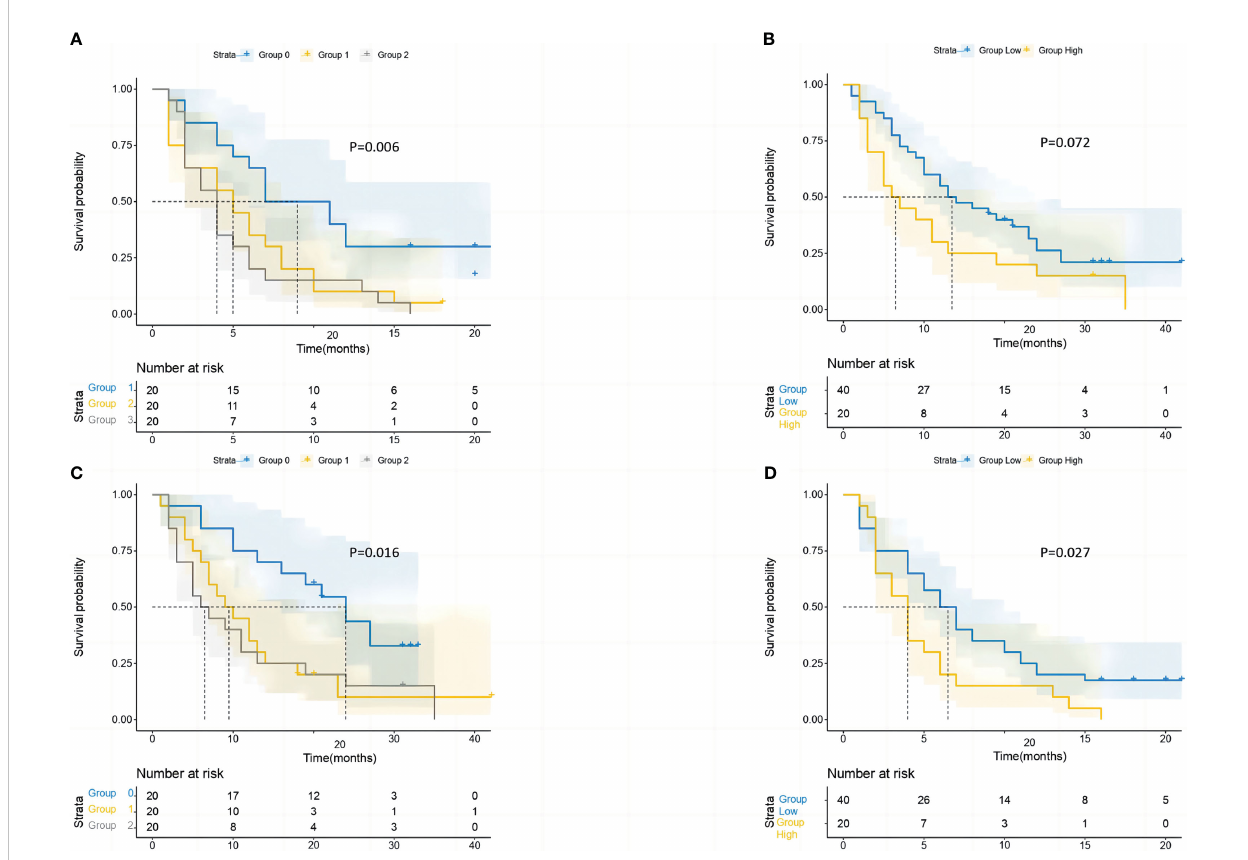
FIGURE 5 After performing PSM, the study conducted survival probability analyses of OS and PFS based on the GRIm-Score estimated by a three-category risk assessment scale (A , C) and the original Bigot ’ s group (B , D) . The results of these analyses are presented in the article. PSM, propensity score matching; OS, overall survival; PFS, progression-free survival; GRIm-Score, Gustave Roussy Immune